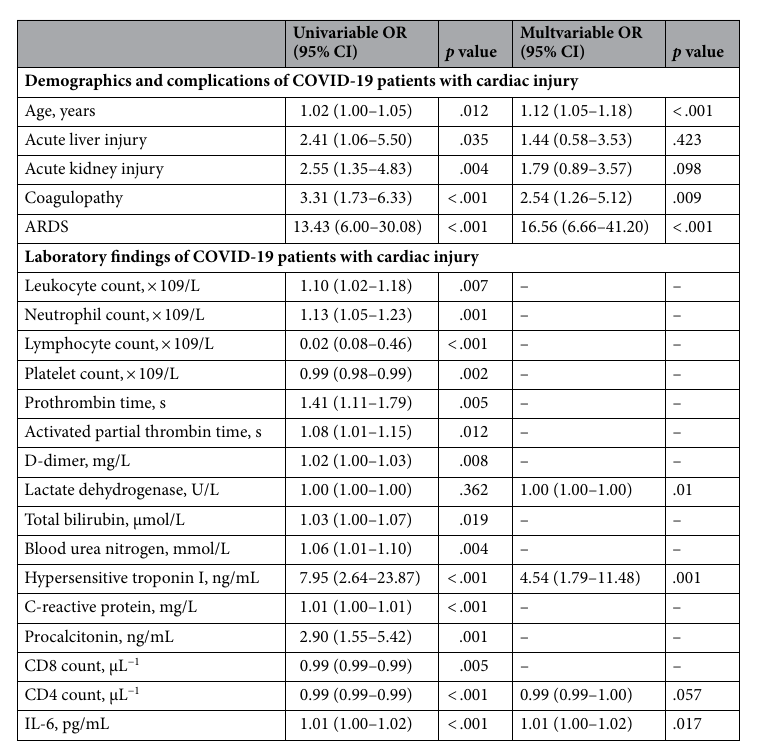
Table 4. Risk factors associated with in-hospital death. OR, odds ratio; ARDS, acute respiratory distress